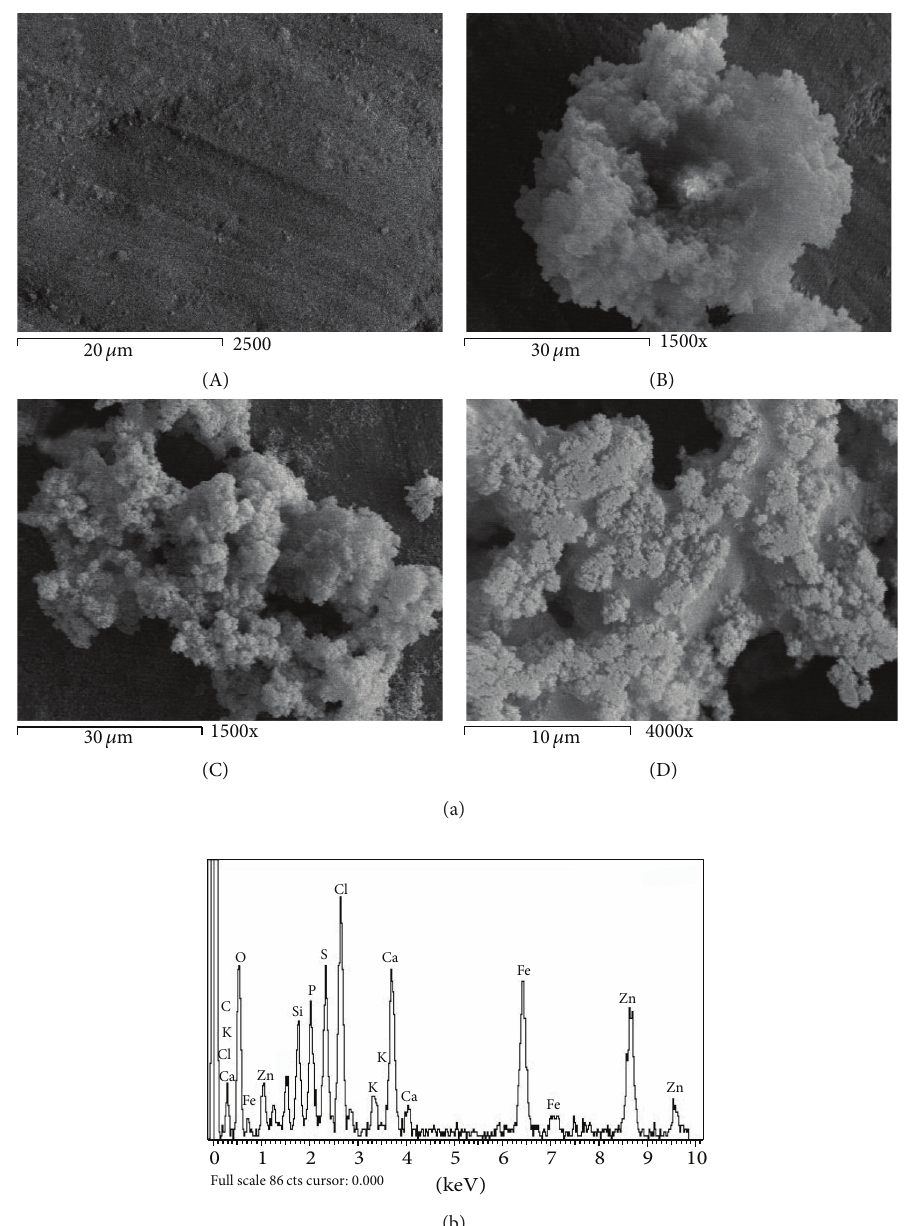
Figure 5: (a) SEM micrograph of Zn-doped glass ceramics (A) before, (B) after 1 week, (C) after 2 weeks, and (D) after 4 weeks of immersion in SBF. (b) EDAX of Zn-doped glass ceramics after 4-week immersion in SBF.